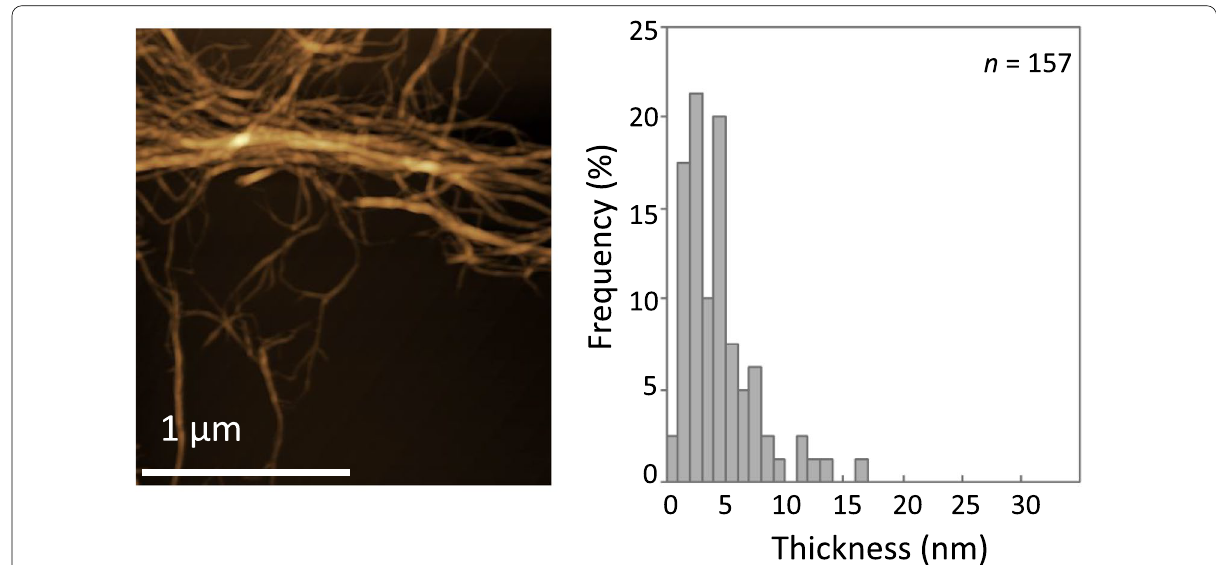
Fig. 2 Atomic force microscopy image and thickness distribution histogram of CNFs derived from Cryptomeria japonica